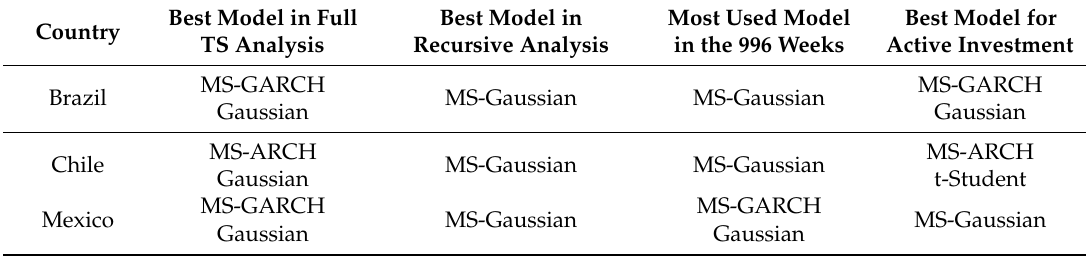
Table 10. Summary of the full time series as well as recursive and active investment analysis. Best Model in Full Best Model in Most Used Country TS Analysis Recursive Analysis